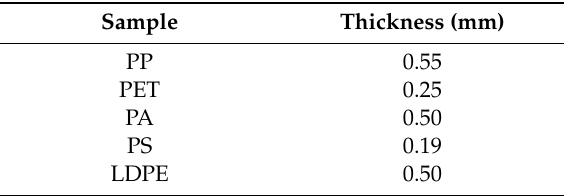
Table 1. Plastic materials and thickness as purchased.